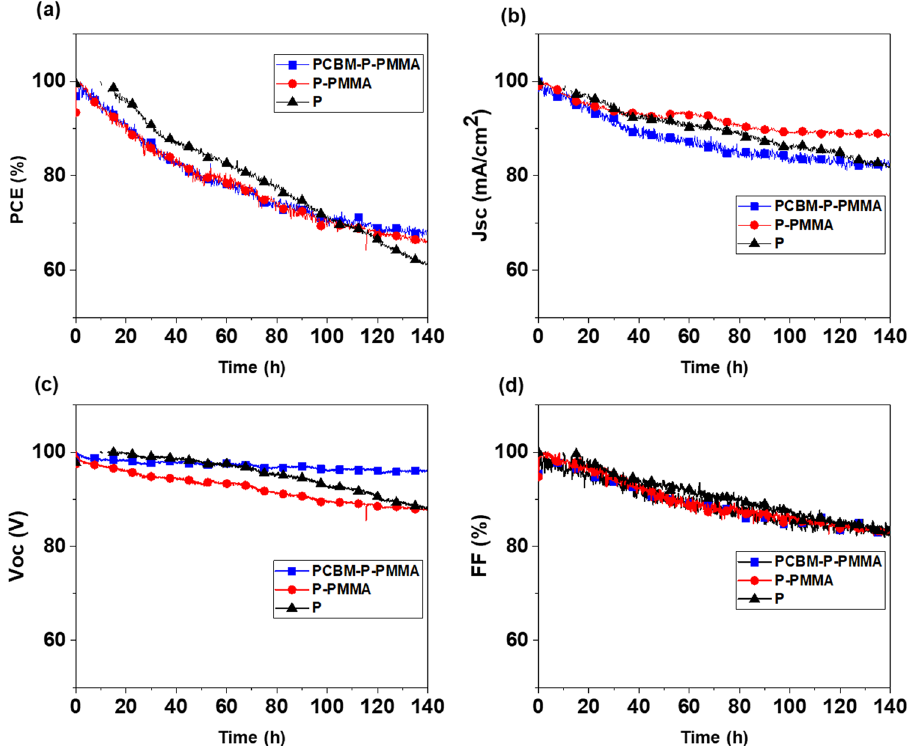
Figure 5. Variation of main normalized photovoltaic parameters ( a ) output power, ( b ) short-circuit photocurrent, ( c ) open circuit voltage, and ( d ) fill factor of FIRA-annealed MAPbBr 3 devices with two passivation layers (blue curve), one passivation layers (red curve) and without passivation layers (black curve) aged at room temperature after 140 h in a nitrogen